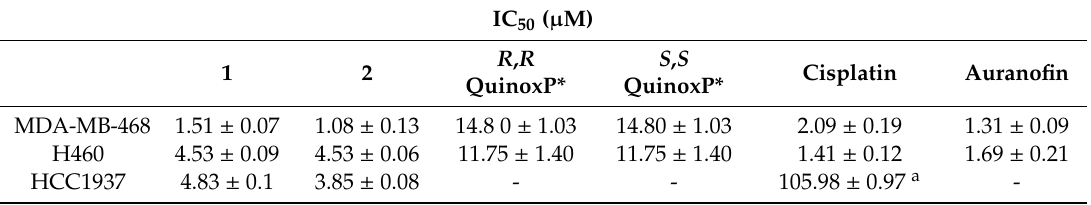
Table 3. In vitro antiproliferative activity. IC 50 values for 1 and 2 across a panel of cell lines. Cells were seeded at a density of 2000 cells per well and treated for 72 h. IC 50 values are plotted as the mean ± s.e.m ( n =